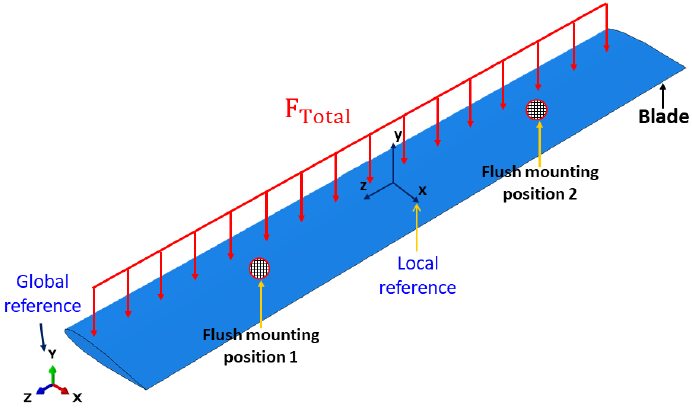
Figure 8. Illustration of the total load on the VAWT blade along the length of the